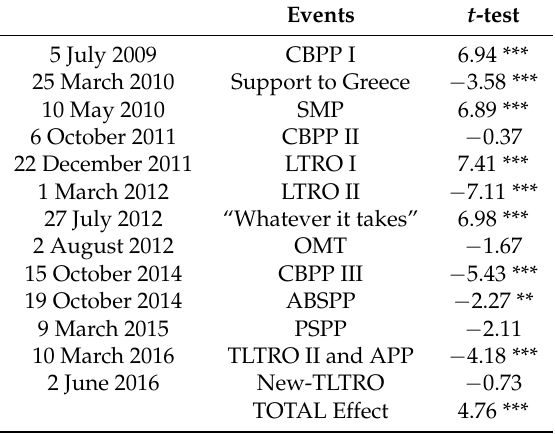
Table A6. Significant Event: ( − 10, +10) days around the event, in which the event is centred. Significance is assessed with a two-sided t -test where the observed changes on announcements days are compared with the corresponding means on non-announcements days; * denotes statistical significance at 10%, ** denotes statistical significance at 5%, *** denotes statistical significance at